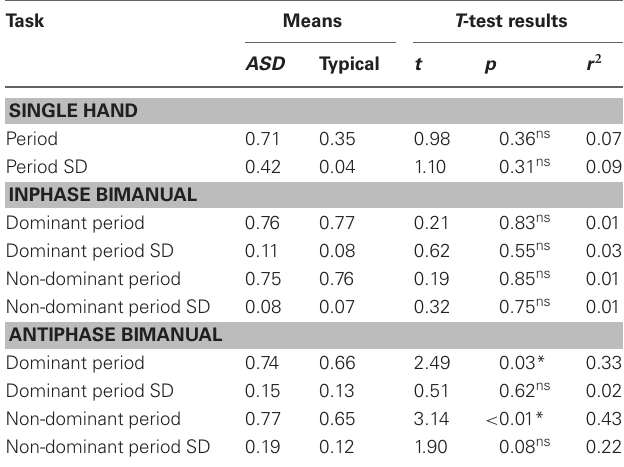
Table 4 | Results for drumming tempo and variability.